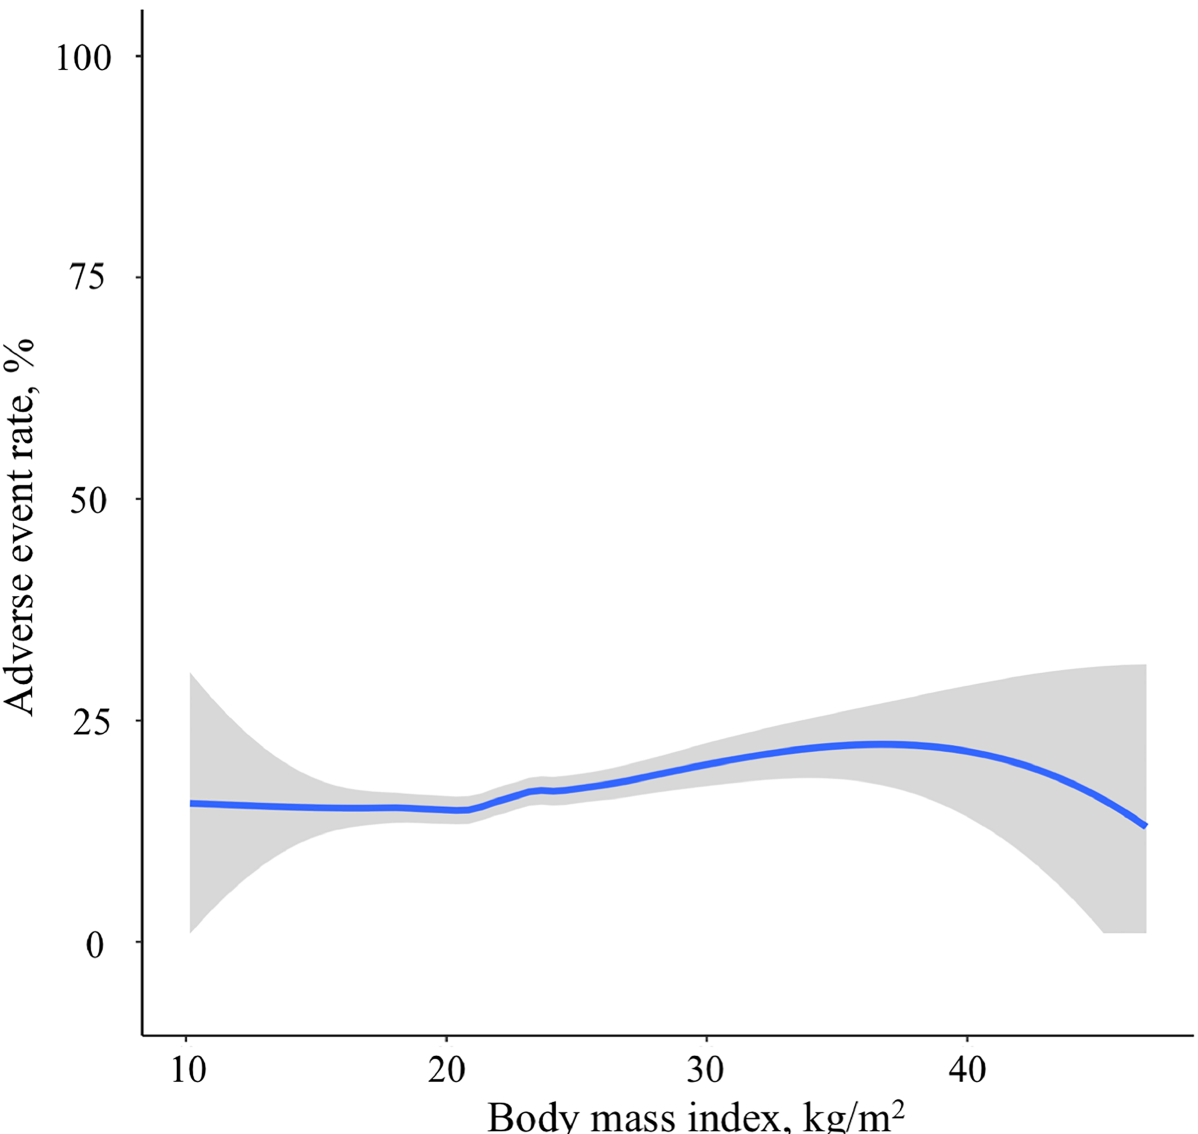
Fig 2. Association of body mass index with the adverse event rates. The fitted line represents locally weighted scatterplot smoothed (LOWESS) curve. There was a positive relationship between body mass index and adverse event rates.